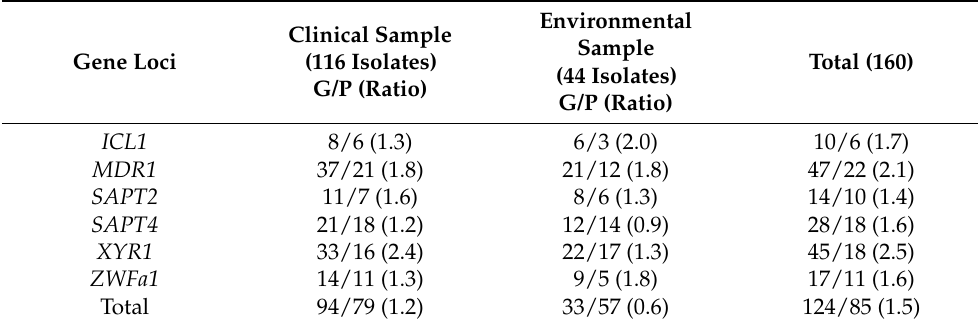
Table 3. Comparisons of polymorphisms at the six C. tropicalis gene fragments between clinical and environmental samples.